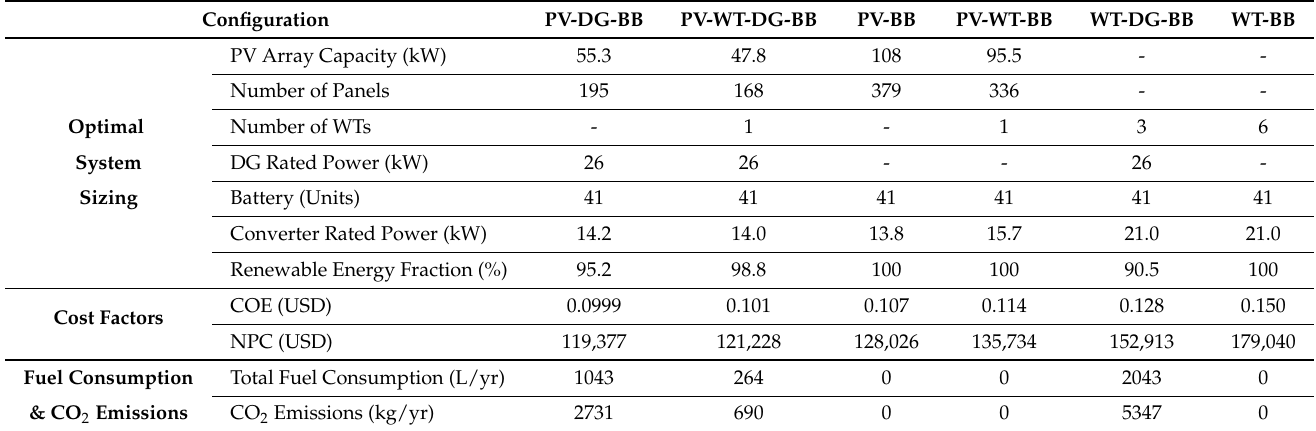
Table 10. Simulation Results for Jal-Alayah Cell Site—Case